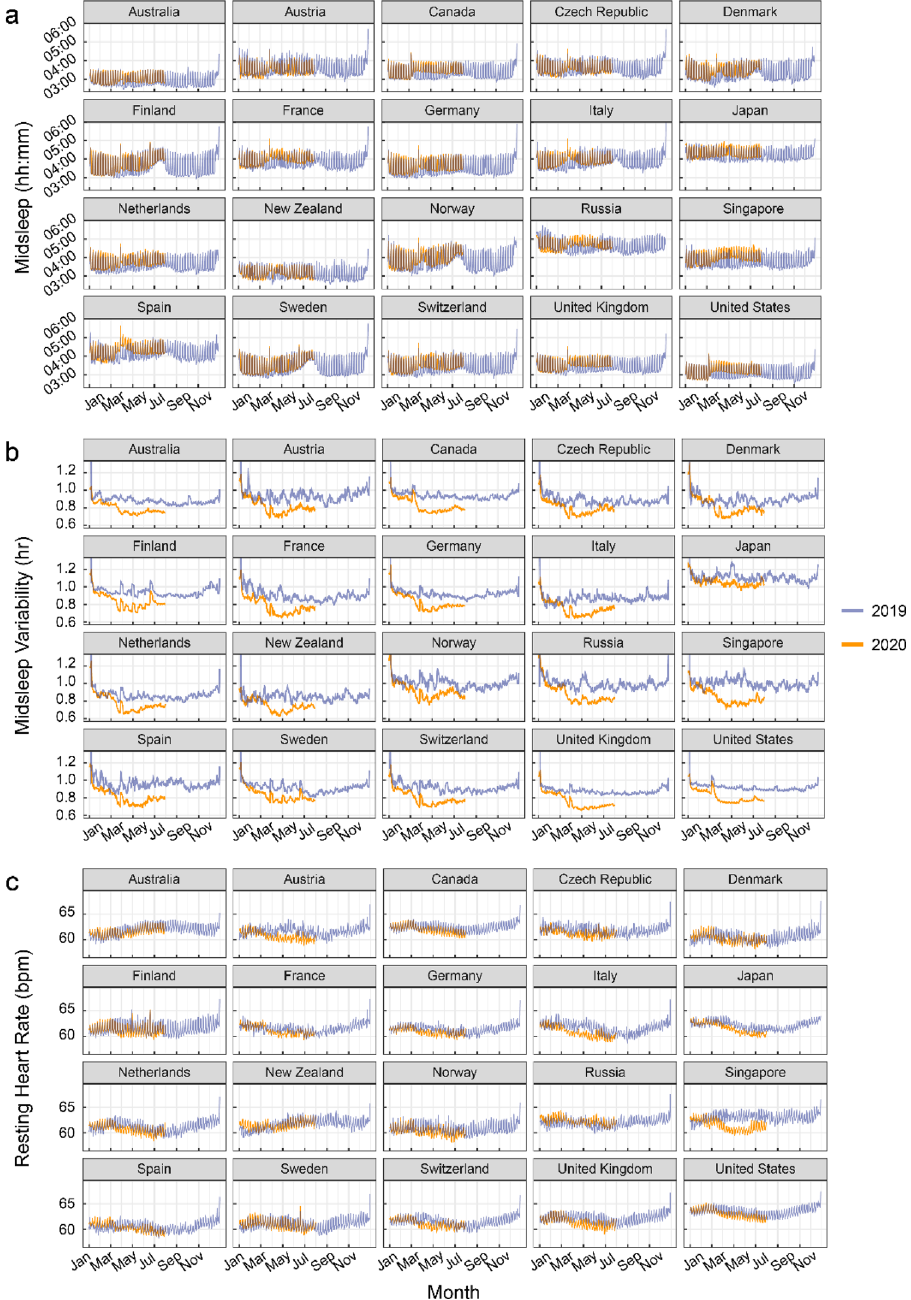
Figure 1. Sleep patterns and resting heart rate measures by country. ( a ) midsleep time, ( b ) midsleep variability and ( c ) resting heart rate from Jan to Jul 2020 (orange curves), compared to Jan–Dec 2019 (purple curves). Dates in 2019 were shifted in order to ensure a matching by day of the week. Daylight savings time (social clocks shifted later by 1 h) began in March in select countries of the Northern Hemisphere, and ended in April in Australia and New Zealand (social clocks shifted earlier by 1 h), explaining sudden shifts in midsleep time and variability on these